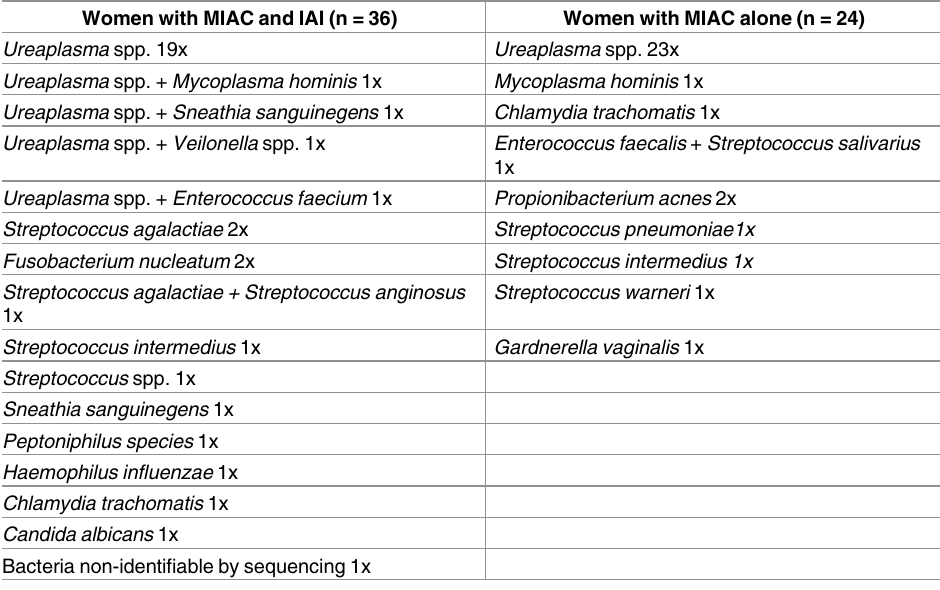
Table 2. The bacterial species identified in the amniotic fluid of women with